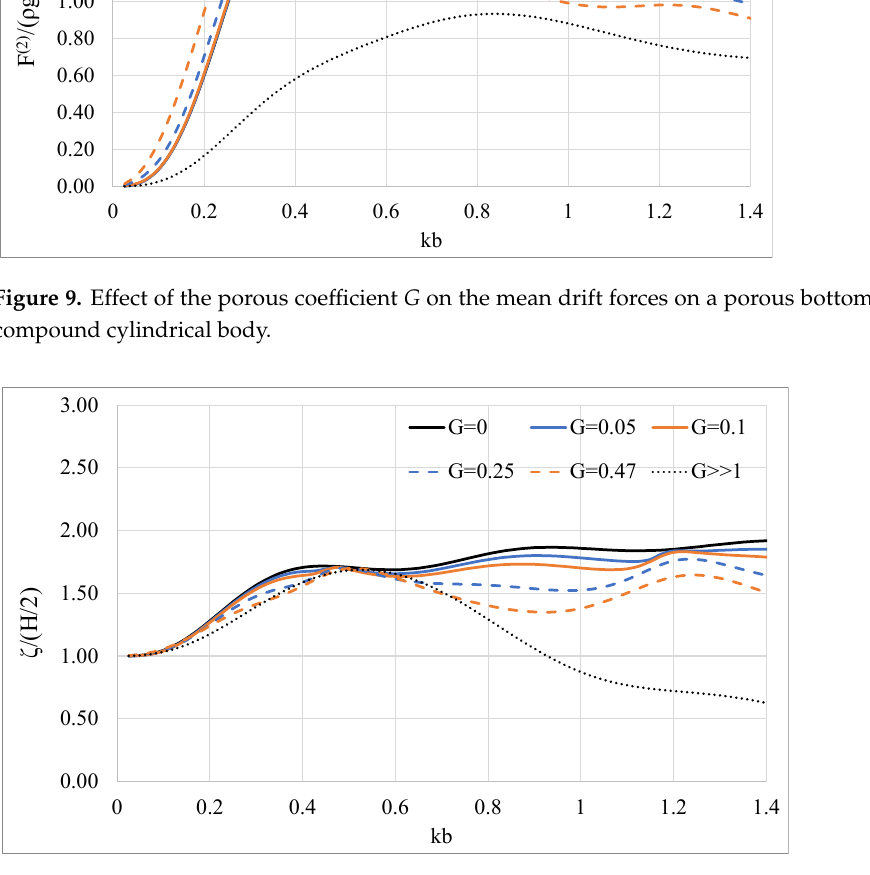
Figure 10. Effect of the porous coefficient 𝐺 on the wave run up of a porous bottom-mounted compound cylindrical body.